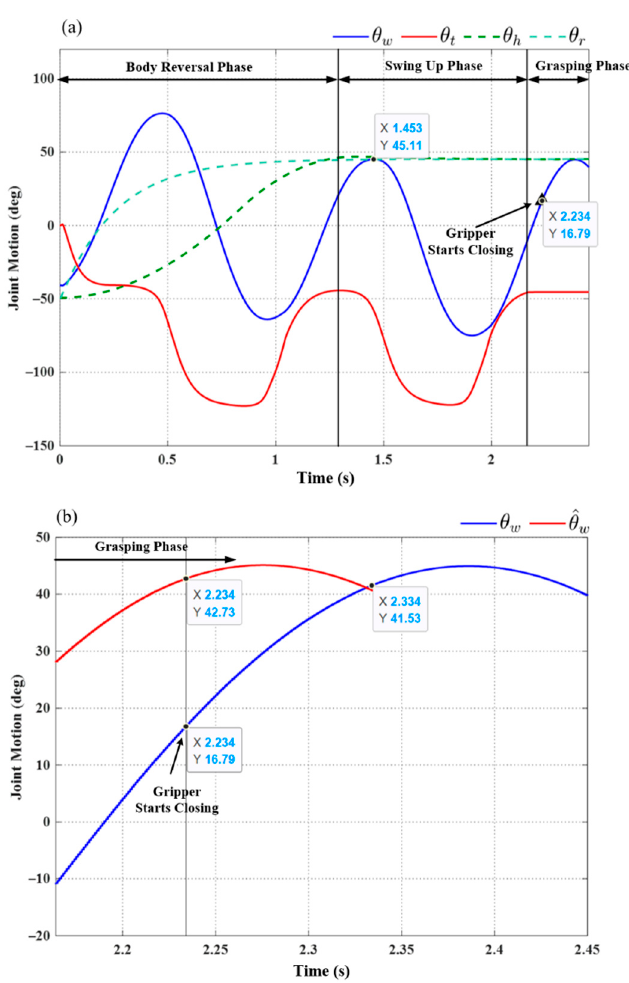
Figure 14. Simulation results: ( a ) joint motion in each phase; ( b ) comparison of wrist joint motions obtained using Equation (29) versus simulation results.